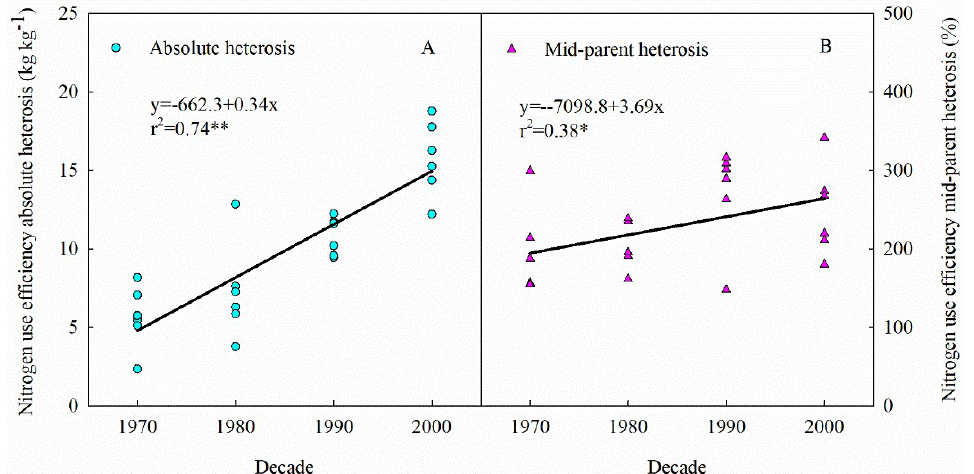
Figure 2. Changes in absolute heterosis and mid-parent heterosis of nitrogen use efficiency of maize hybrids in different decades. Note: ( A ), nitrogen use efficiency absolute heterosis; ( B ), nitrogen use efficiency mid-parent heterosis (%). * and ** indicate significant differences at 0.05 and 0.01 probability,